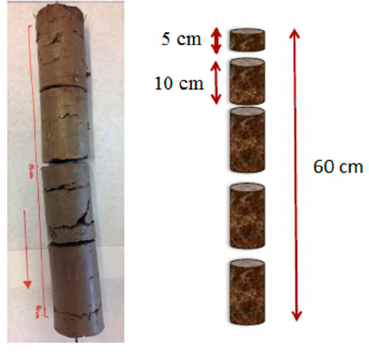
Figure 2. The soil core sampling and sectioning.